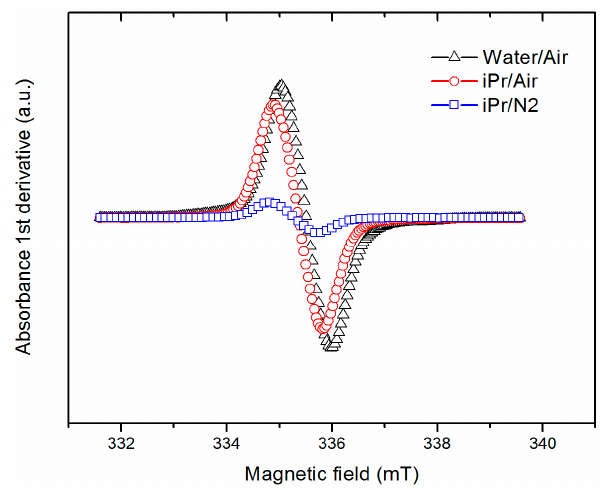
Figure 2. Electron spin resonance (ESR) spectra of the LDH ‐ gallate products obtained from different